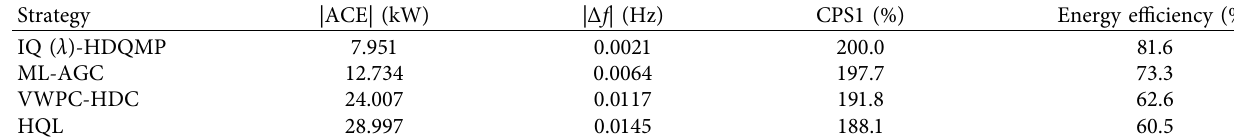
Table 3: Te control performance of four strategies under a white noise load.